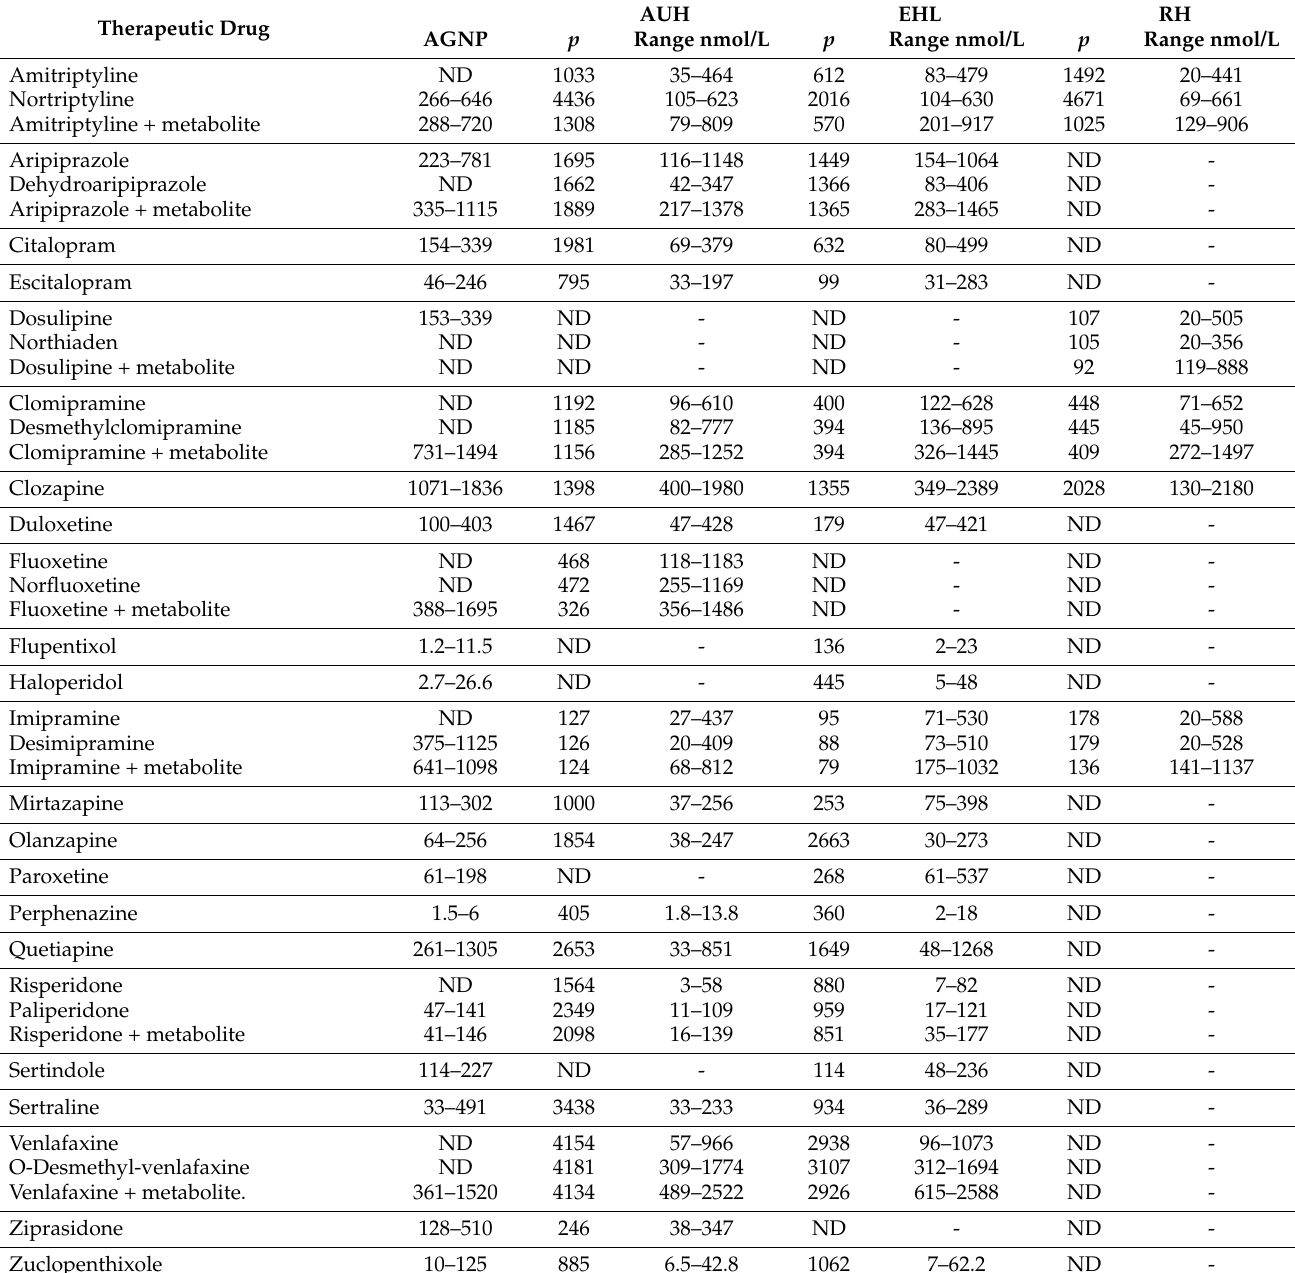
Table 2. Comparison between therapeutic reference ranges listed in the AGNP consensus guideline and calculated 10–90 percentiles from the three laboratories. The data were selected on the basis of the TDM model, and ranges were calculated by using the RefIT software. The number of patients